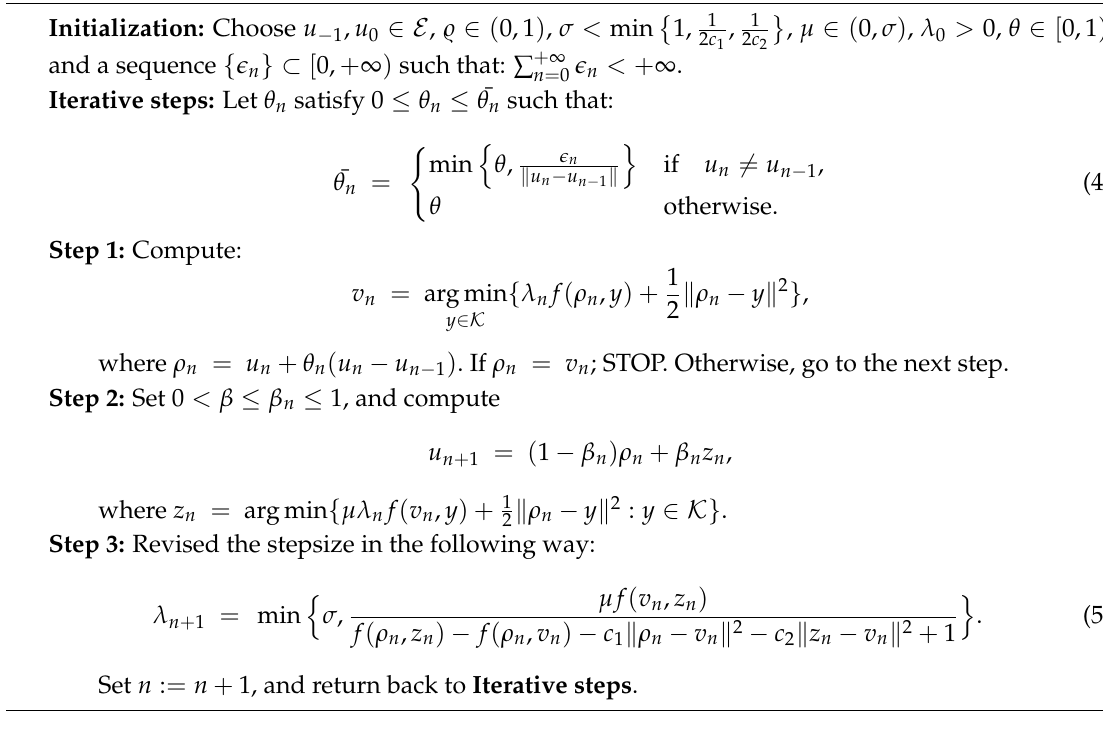
Algorithm 1 (Accelerated method for pseudomonotone equilibrium